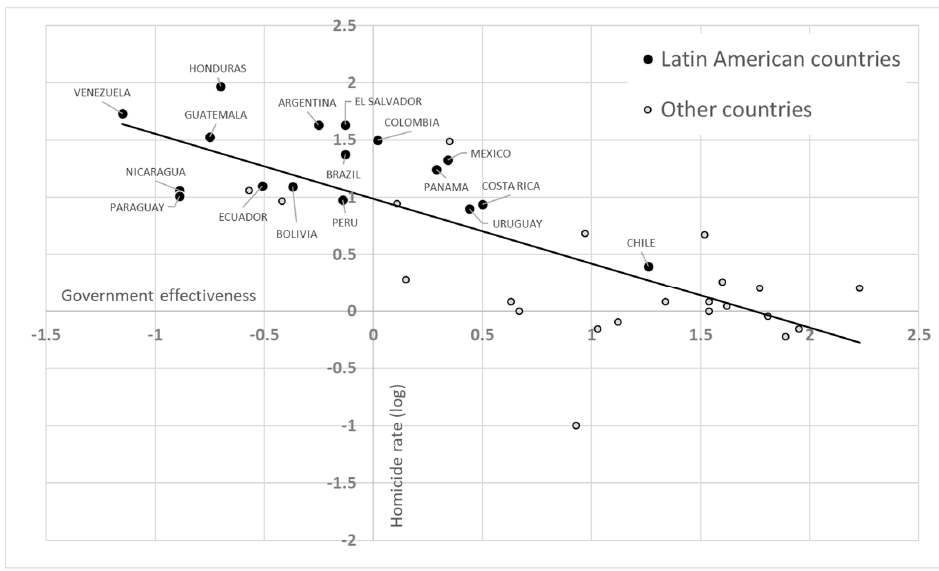
Figure 1. Government effectiveness and homicide rates.